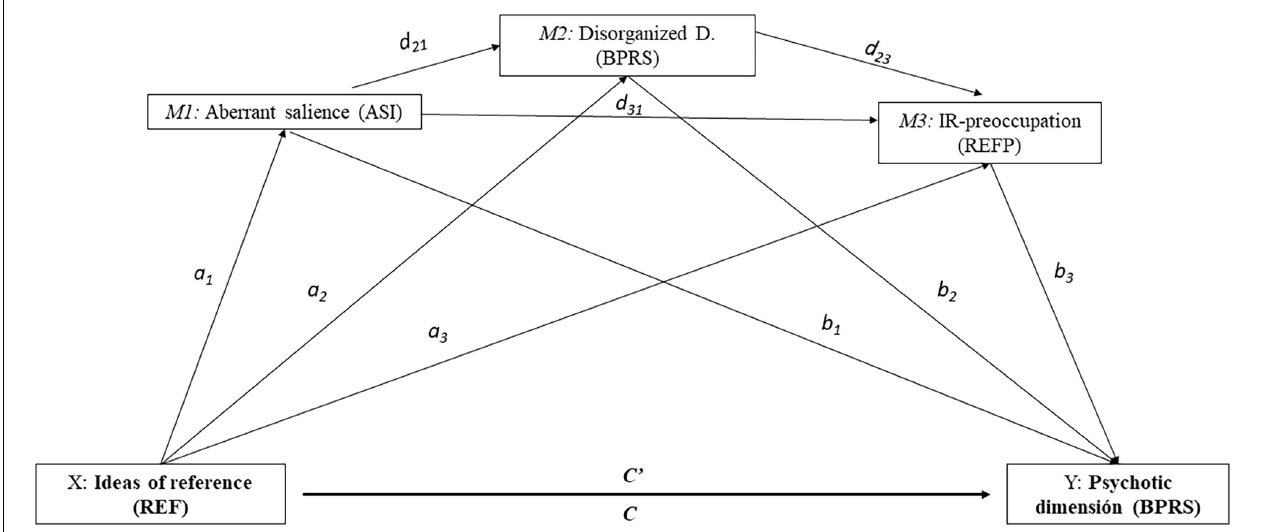
FIGURE 1 | Conceptual model of the hypothesis proposed. a1, a2, a3 = effect of X on mediator variables (M1, M2, M3); b1 b2; b3 = effect of mediator variables on Y; c = Total effect of X on Y; c (cid:48) = direct effect of X on Y.